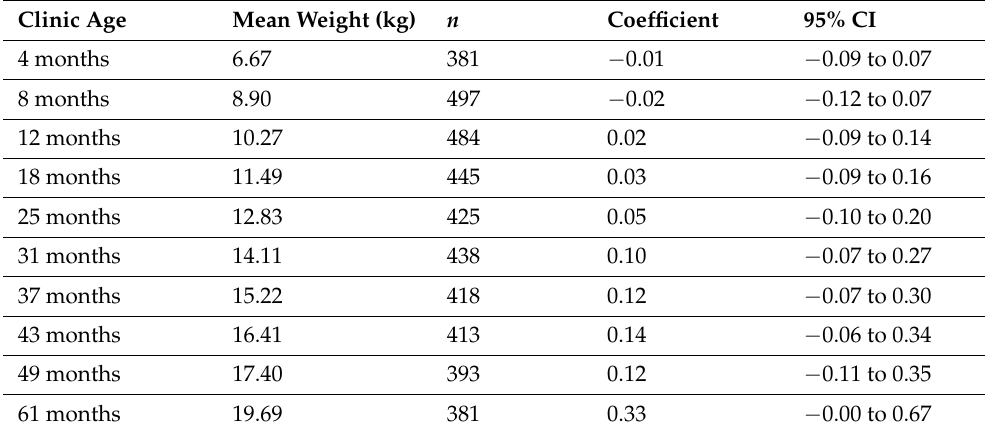
Table 3. Estimated associations between maternal blood mercury ( µ g/L) and child weight (kg), at 10 clinic visits.